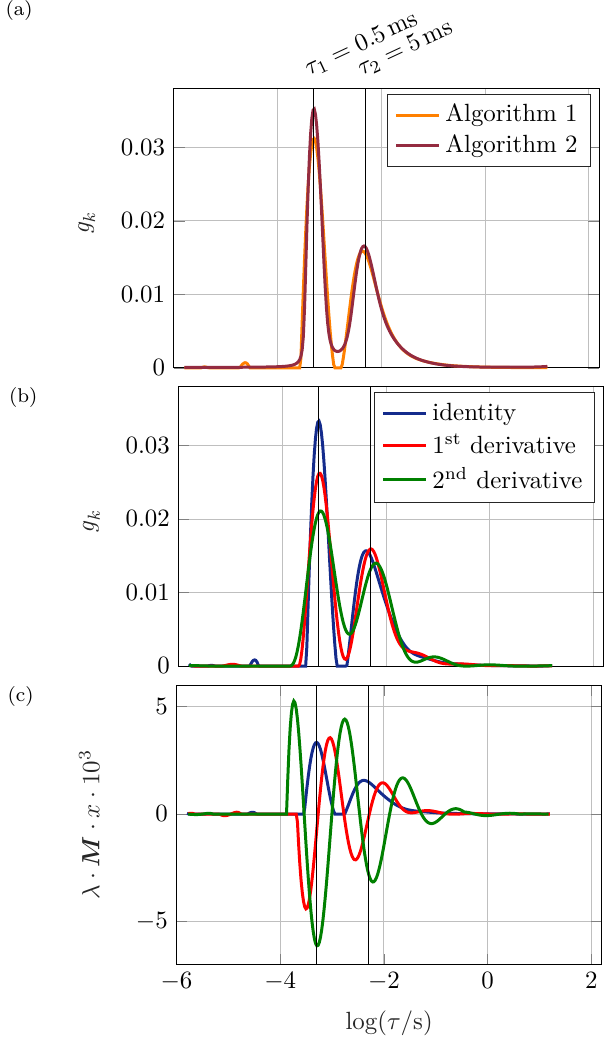
Figure 6. ( a ) DRT of an RC- ( R 1 = 5m Ω , C 1 = 0.1F) and a ZARC-element ( R 2 = 7m Ω , C 2 = 0.71F, ϕ = 0.8) in series, λ = 0.1, n = 3 m . Algorithm 1 as pointed out within Section 2, Algorithm 2 using an interior-point method, ( b ) using identity matrix, first and second derivative for regularization. ( c ) Showing the regularization term representing the matrix according to